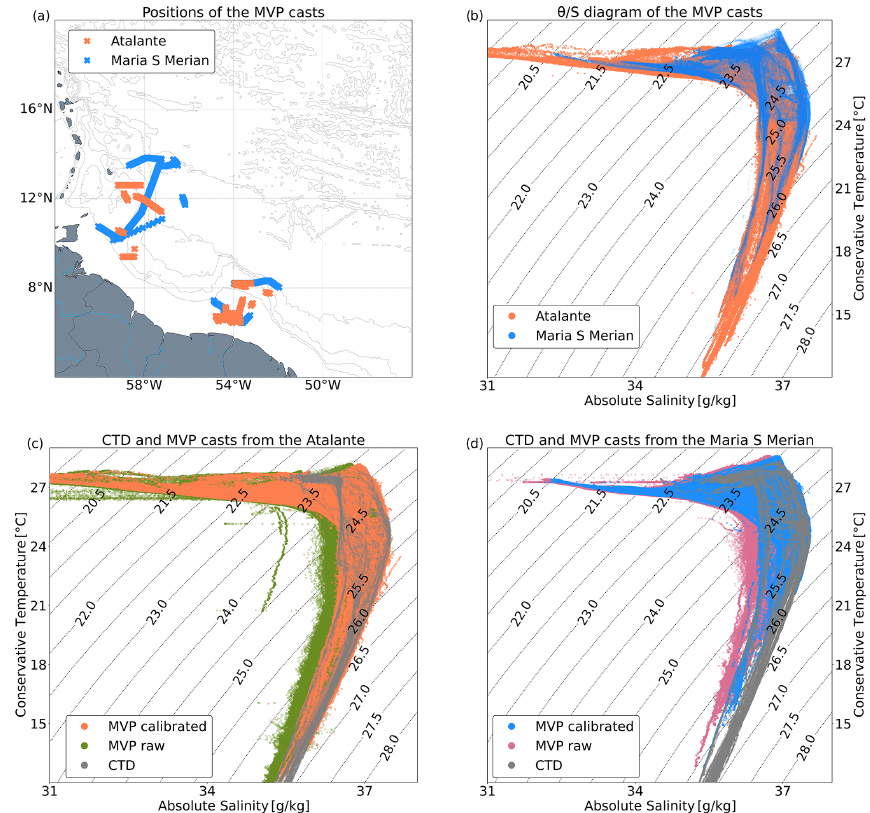
Figure 12. (a) Map of the MVP cast positions for R/Vs L’Atalante and Maria S. Merian . (b) θ /S diagram of the MVP-calibrated profiles for each ship superimposed on the isopycnals. Panels (c) and (d) show the comparison of the raw and calibrated MVP profiles superimposed on the CTD profiles for R/Vs L’Atalante and Maria S. Merian ,